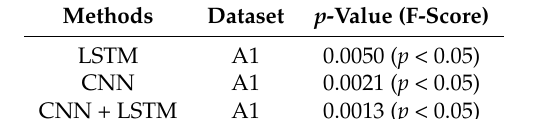
Table 4. The p -values of our method compared to the other methods on class A1.